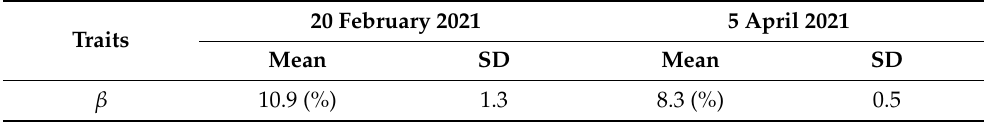
Table 5. Mean and standard deviation of strawberry samples ( s = 8) on different days of harvest.